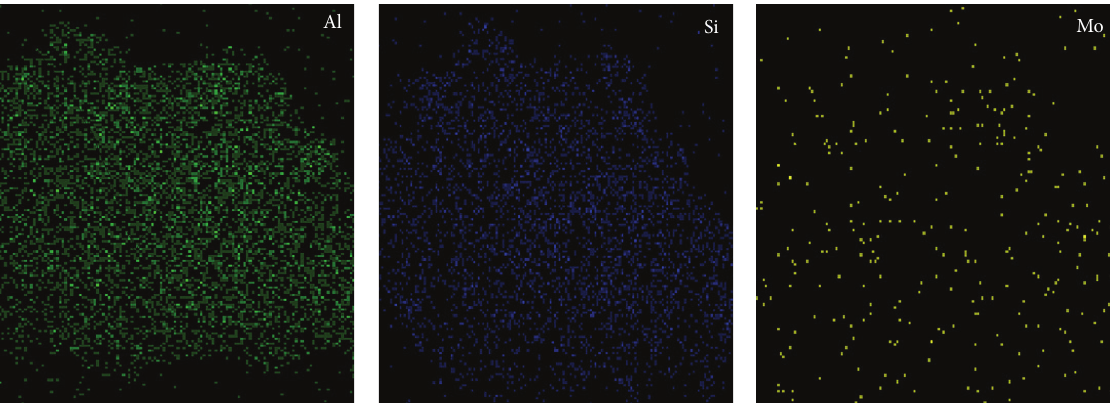
Figure 5: The typical EDX mapping of 1% Mo/Al-SSP